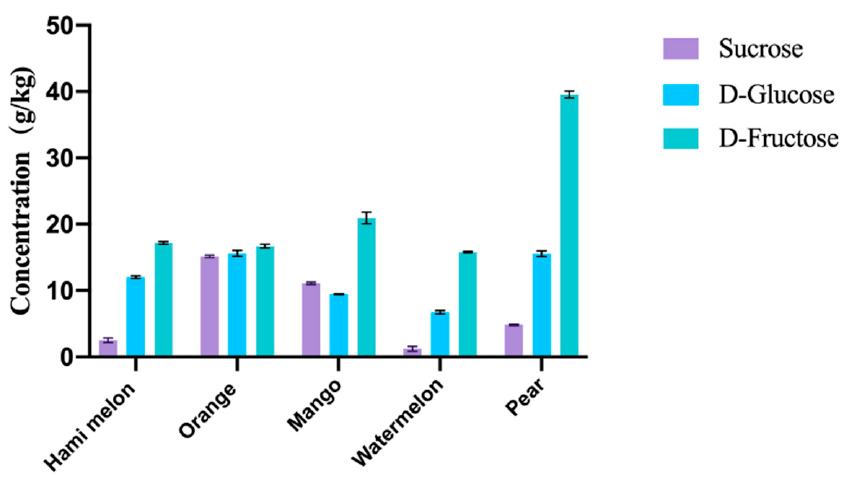
Figure 4. Sugar content of fruit peels after boiling and crushing pretreatment.